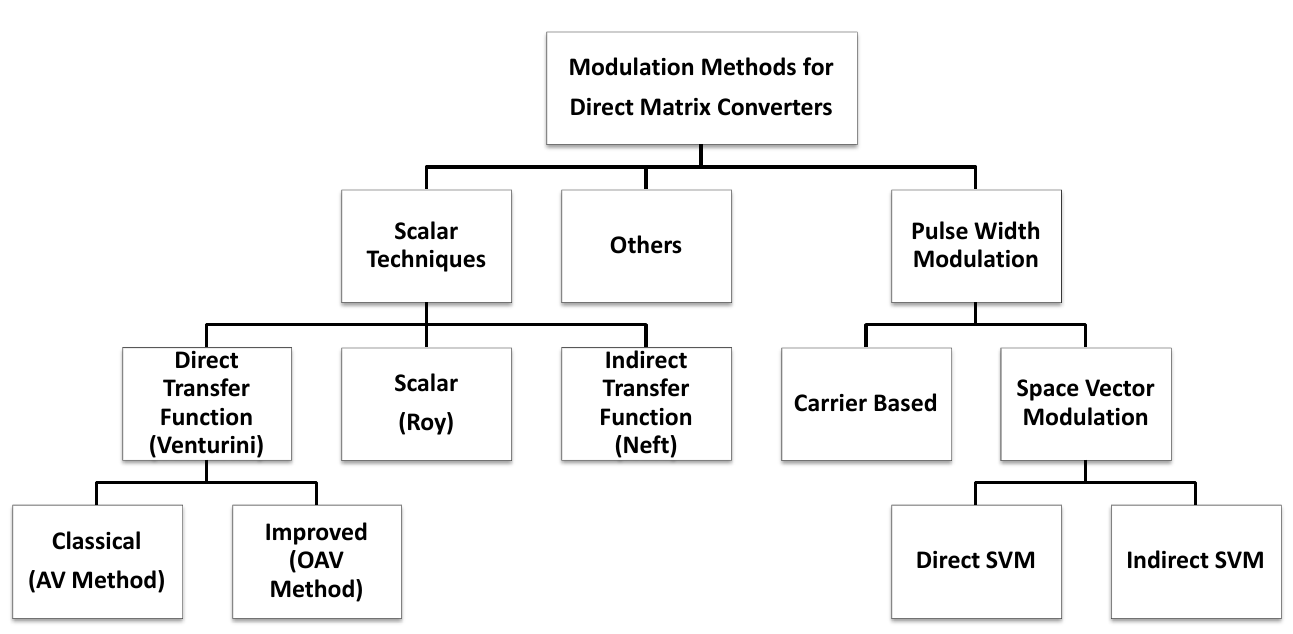
Figure 5. Classification of matrix converter (MC) modulation